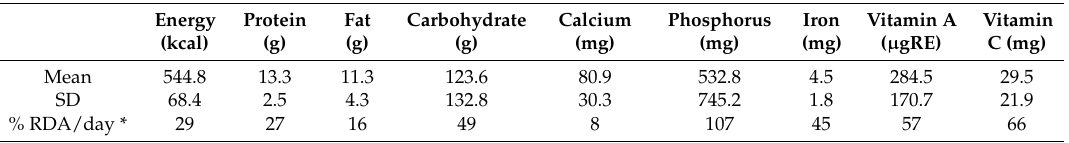
Table 2. Mean and SD of energy and nutritional values of the provided school lunch.